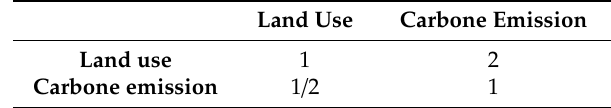
Table 7. Comparison matrix of environmental factors.